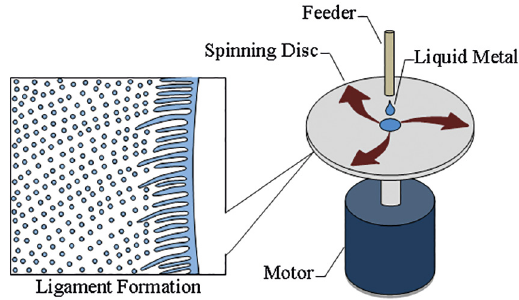
Figure 1. A schematic diagram of centrifugal atomisation 16 .